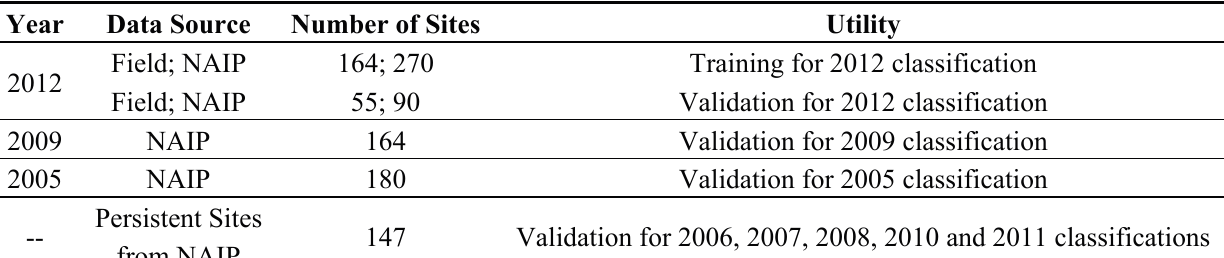
Table 4. Summary of reference site data obtained for classification and accuracy